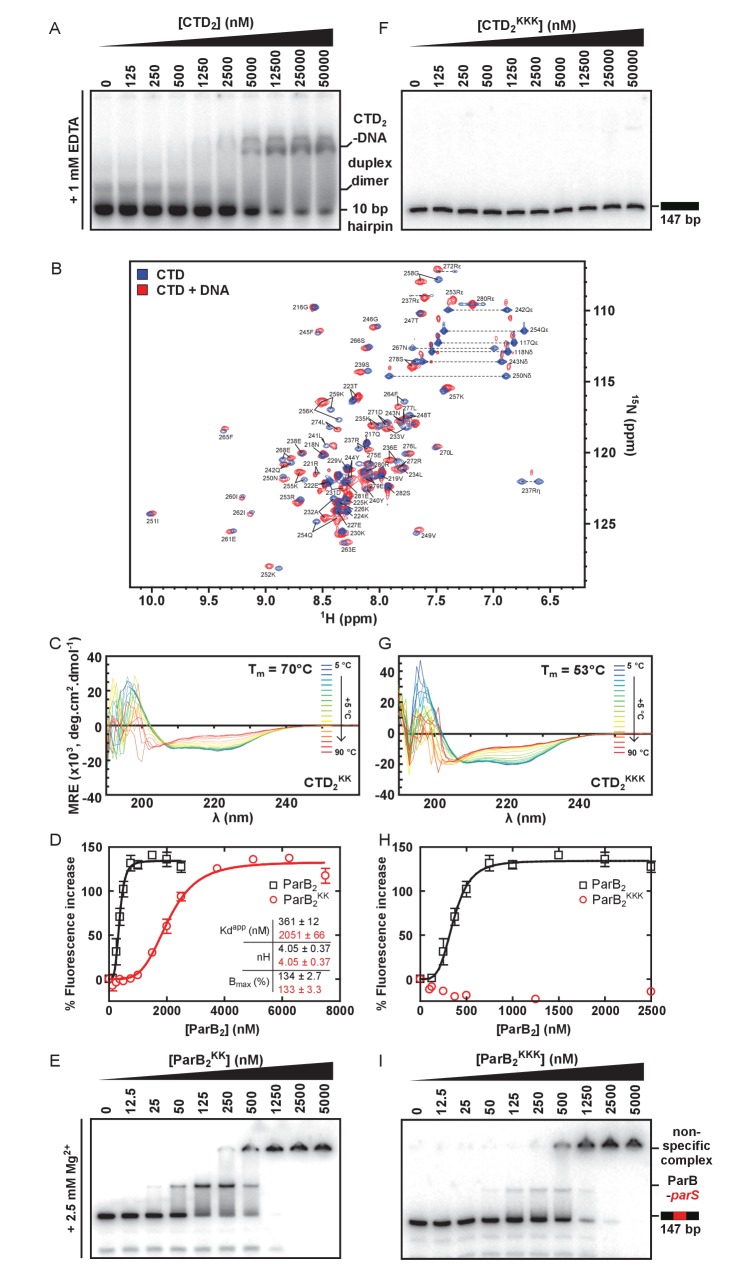
The CTD binds DNA via a lysine-rich surface.(A) TBE-EMSA showing binding of the CTD to the 10 bp hairpin DNA substrate used for NMR experiments. (B) Assigned 1H-15N HSQC spectra of the CTD prior (blue) and after (red) titration with a 10 bp hairpin DNA substrate. Arginine ε and η peaks are aliased once and twice, respectively. (C) CD spectra over a thermal denaturation scan (5°C to 90°C) for 10 µM CTD2KK in PBS. (D) PIFE assay showing binding of full length ParBKK to non-specific DNA. The data were fitted to the Hill equation. Error bars represent the standard errors from three independent experiments. Standard errors of fitted parameters were calculated in GraphPad Prism. (E) TBM-EMSA showing binding of full length ParBKK to parS-containing DNA. ParBKK is able to form specific complexes. (F) TBE-EMSA showing no binding of CTDKKK to DNA at concentrations as high as 50 µM dimer. (G) CD spectra for 10 µM CTD2KKK recorded as in C. (H) As in D, using ParBKKK. H uses the same wild-type ParB dataset as D. (I) TBM-EMSA showing binding of full length ParBKKK to parS-containing DNA. This mutant protein is also able to form specific complexes.